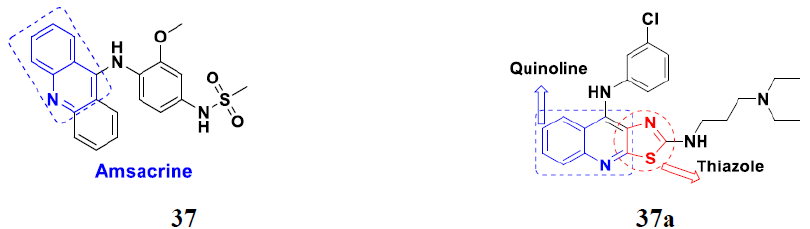
Figure 41. Structure of quinoline hybrid amsacrine 37 and the most promising compound 37a. Luniewski et al. (2012) synthesized quinoline based indole hybrids and evaluated their anticancer activity. Most of the synthesized compounds showed potent anticancer activity. Among them, compound 38 ( a ) showed excellent activity against KB, A ‐ 549, MCF ‐ 7, Hs294T, and BALB/3T3 cell lines having IC 50 values of 0.15, 0.24, 0.38, 0.62, and 0.31 μ M with control 5,11 ‐ dimethyl ‐ 5H ‐ indolo [2,3 ‐ b]quinoline (DIMIQ) at IC 50 values 1.14, 2.19, 1.50, 9.70, and 5.70 µ M, respectively. Furthermore, compound 38a showed excellent topo II inhibitory activity at concentration of 0.05 µ M with control DIMIQ (Conc. 0.5 µ M), m-AMSA (Conc. 0.05 µ M), and daunorubicind (Conc. 0.5 µ M) and cell cycle inhibitory activity at a concentration of 0.10 µ M with control DIMIQ (Conc. 1.02 µ M). Additionally, it showed positive inhibitory results in the G2M phase of the cell cycle. The structure of quinoline-indole based hybrid derivatives is given in Figure 42 and the in vitro cytotoxicity of compounds 38 ( b – e ) against human cancer cell lines is shown in Table 31